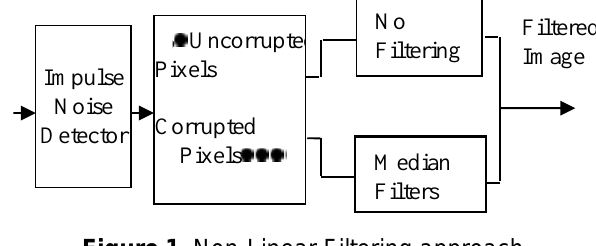
Figure 1. Non-Linear Filtering approach Non- linear filters can clear away salt and pepper